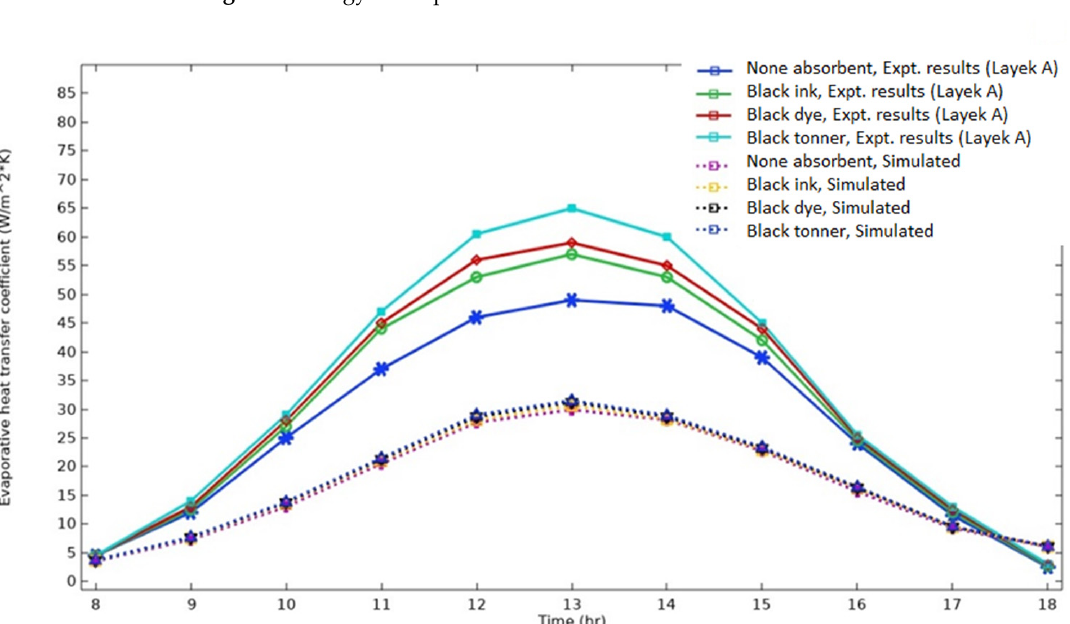
Figure 8. Exergy of evaporation of the solar still for different absorbers in water.